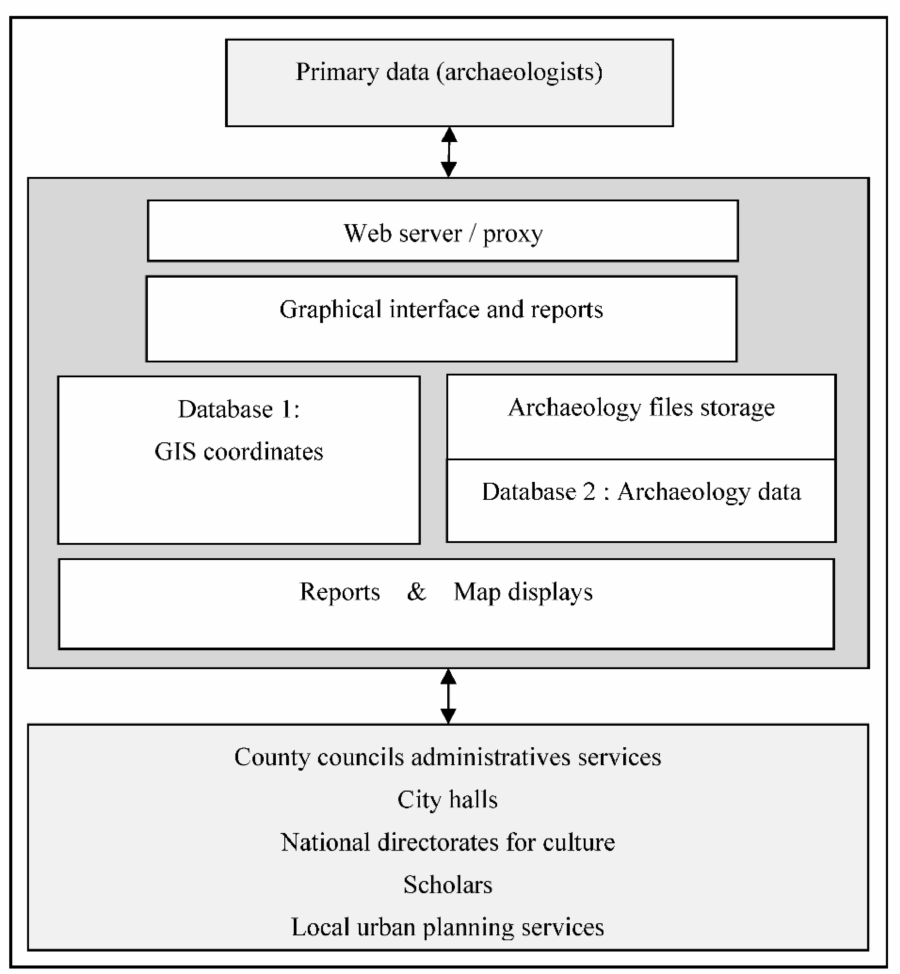
Figure 11. Functional software system